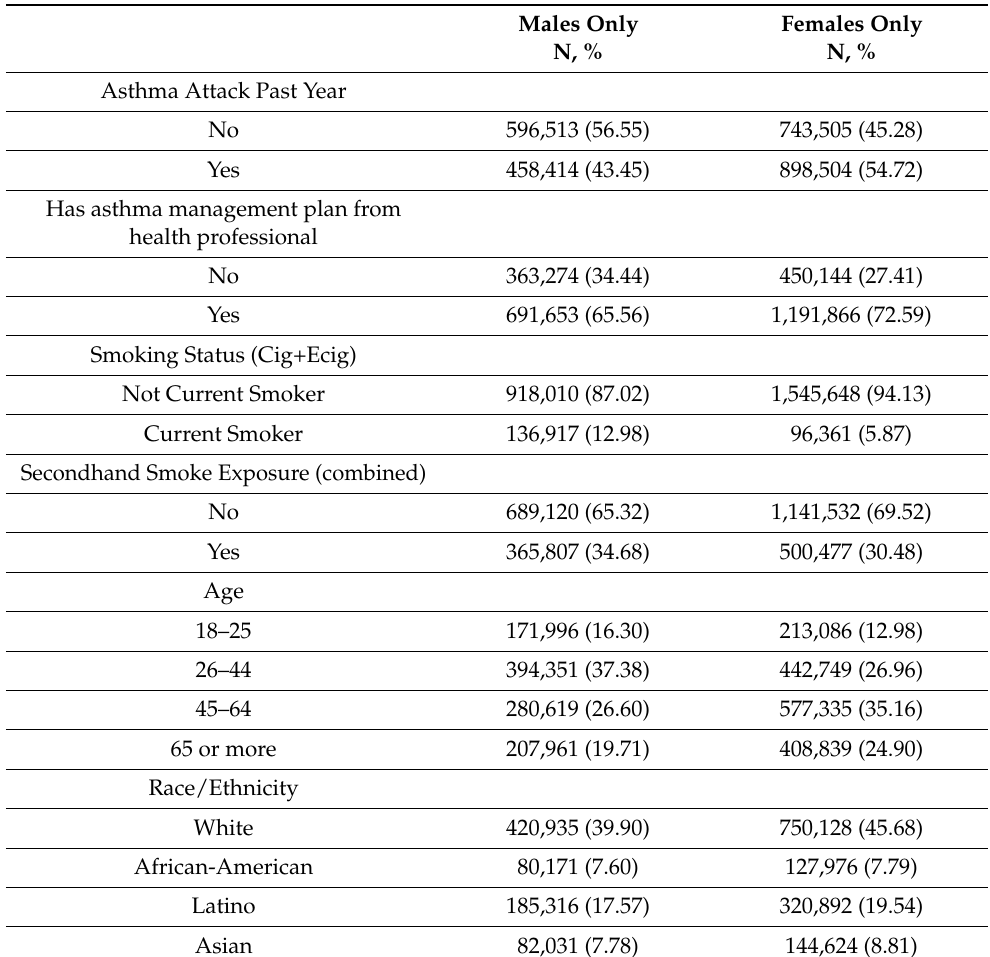
Table 1. Study population characteristics, by sex (n males = 700, N males = 1,054,927, n females = 1510, N females